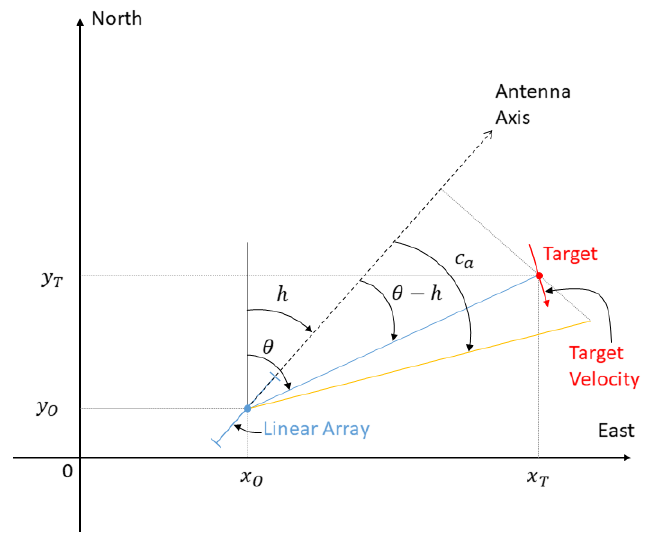
toward the surface, 𝛿 = −1 , otherwise 𝛿 = +1 , Figure 1. A typical scenario, viewed from the sky. Figure 1. A typical scenario, viewed from the sky.